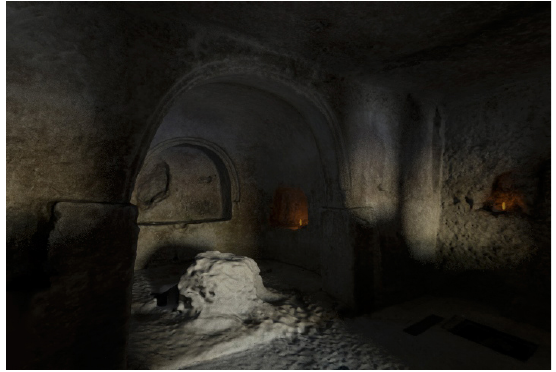
Figure 15: 3D Studio Max Sw. Photorealistic render of the apse with combined lighting. h 17.00 p.m.-Date: 21 Dec.